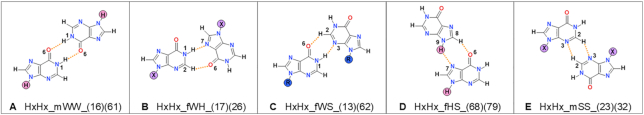
Types of hypoxanthine-hypoxanthine base pairs found in small molecule crystals containing hypoxanthine or its N9-derivatives. For details, see Figure 4 caption. The examples of existing structures from CSD can be found in Supplementary Figure S.10.